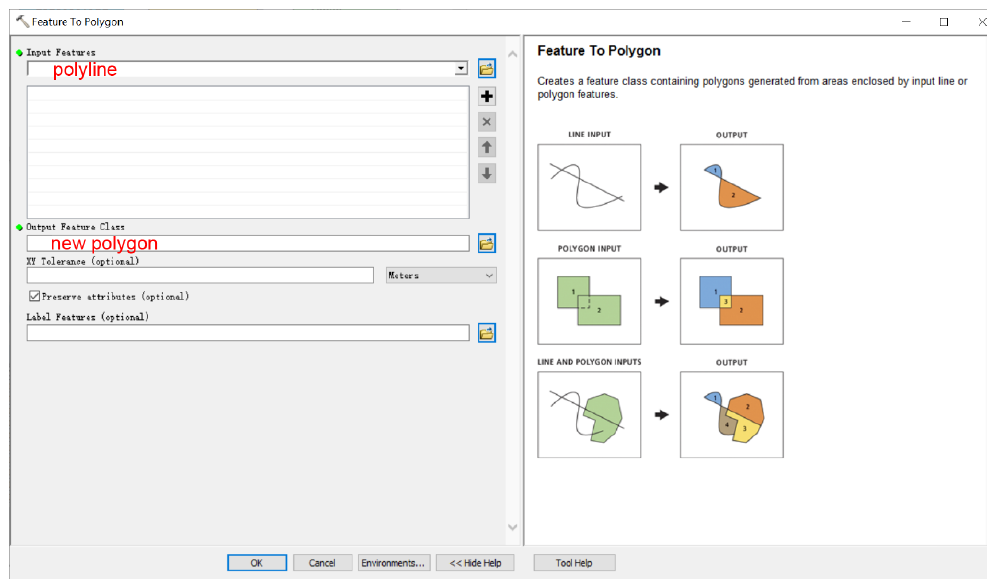
Figure A6. Feature To Polygon tool in ArcGIS.